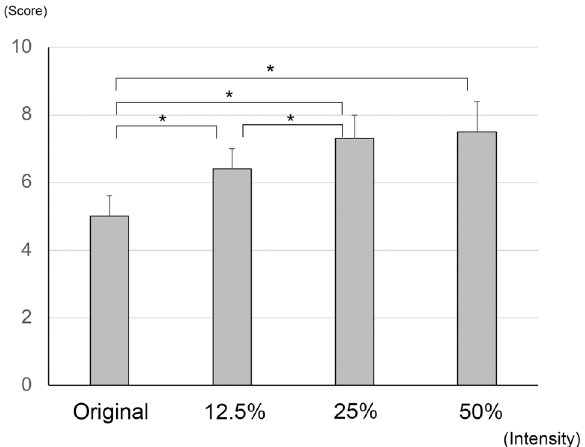
Figure 2. Mean visibility score for all procedures. The mean visibility score increases significantly from 5.0 ± 0.6 at 0% (original source) to 6.4 ± 0.6 at 12.5% intensity of the image-sharpening ( P < 0.001, Wilcoxon signed rank tests) and 7.3 ± 0.7 at 25% ( P < 0.001). The mean visibility score increases to 7.5 ± 0.9 at 50%, but the increase from the original source is not significant ( P = 0.294). *; P < 0.001.